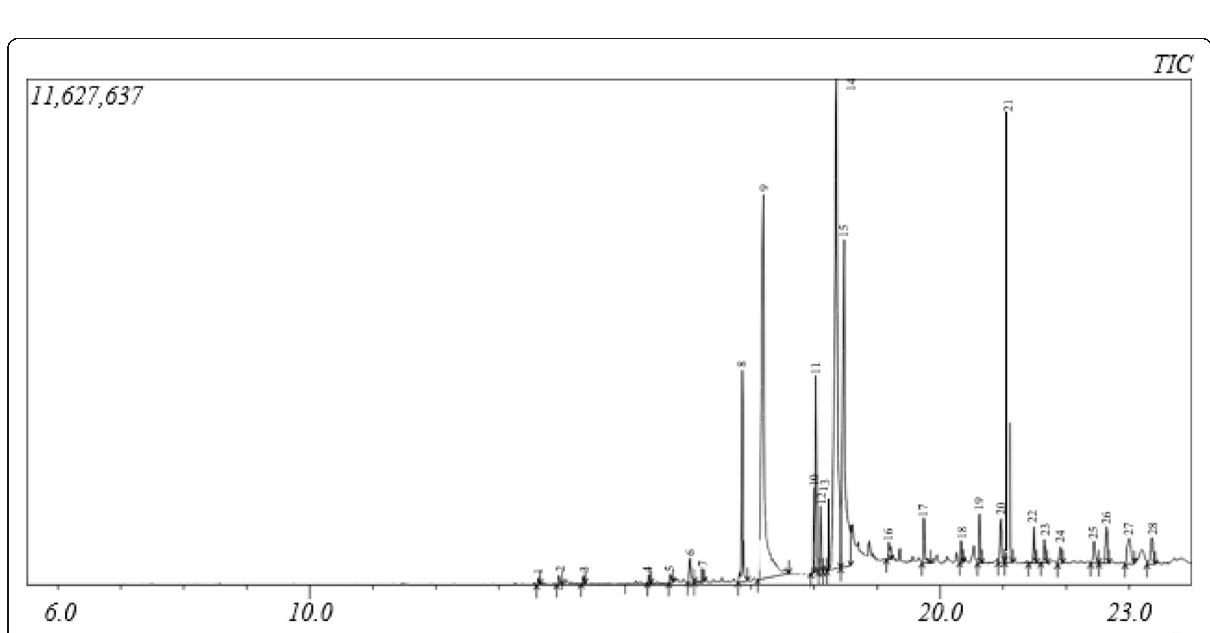
Fig. 1 Chromatogram of the purified fraction of Maytenus senegalensis (Lam.) Exell